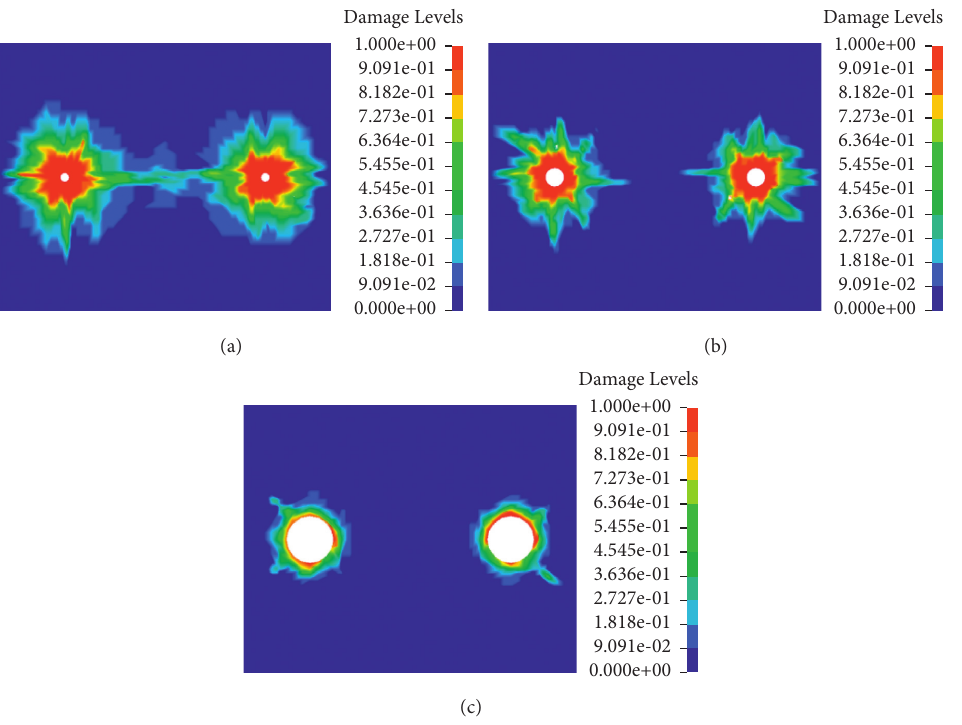
Figure 11: Damage nephogram of blasting models with different K